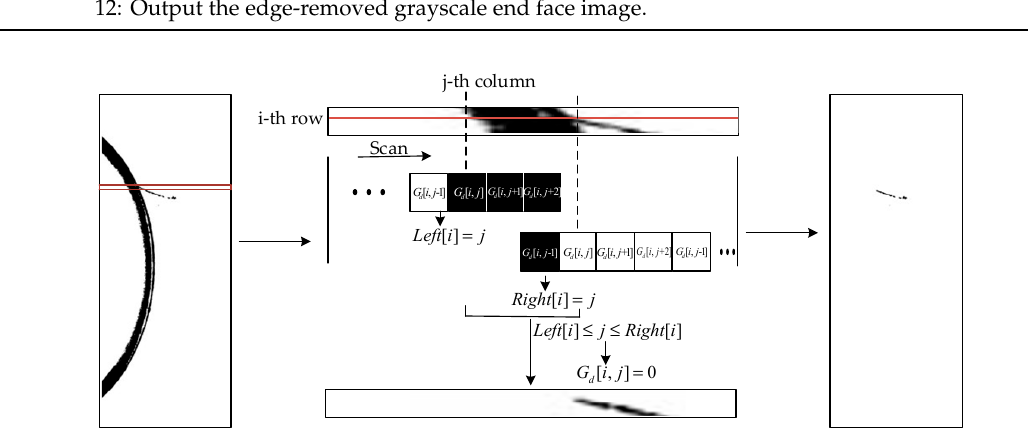
Figure 11. Sketch of the image edge removal algorithm.